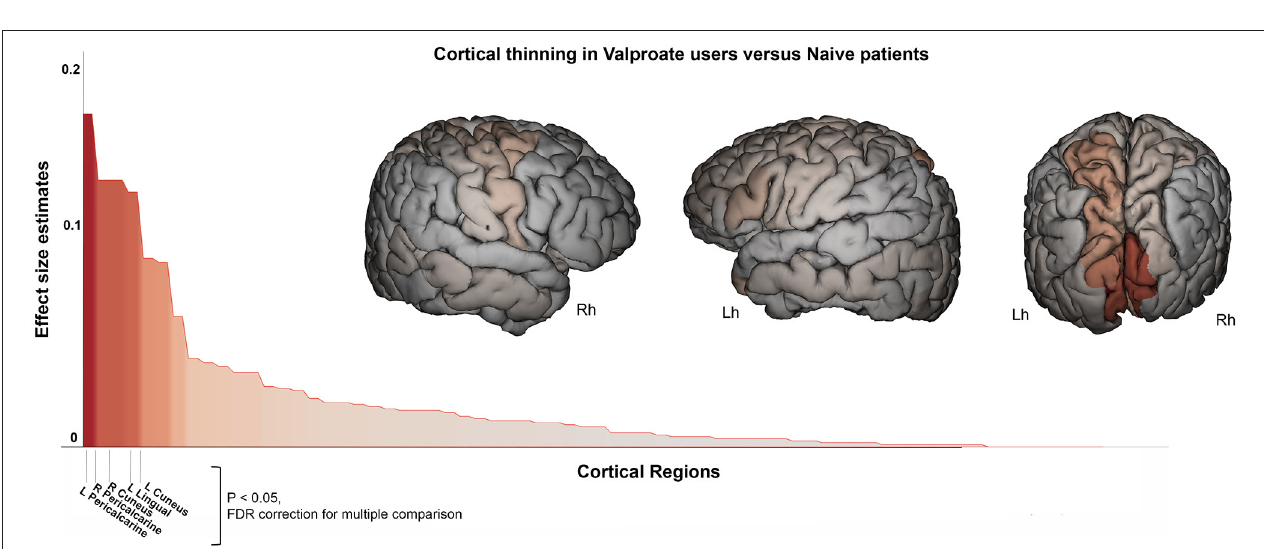
FIGURE 3 | Cortical thickness difference between valproate users and drug-naïve patients. Surface brain template showing regions of cortical thinning in valproate users compared to drug-naïve patients. Brain images are generated using EnigmaViewer (https://www.nitrc.org/projects/enigmaviewer_20/); strength (color) of heat map is determined by the size of the regional effect size estimate. Effect size estimates (partial eta squared, y-axis) for cortical thickness differences across all brain regions is showed on the bar plots. Brain region with significant differences between groups ( p < 0.05 FDR; ANCOVA analysis adjusted for age, sex, disease duration, and intracranial volume) are reported on the x-axis. Lh, left hemisphere; Rh, right hemisphere.